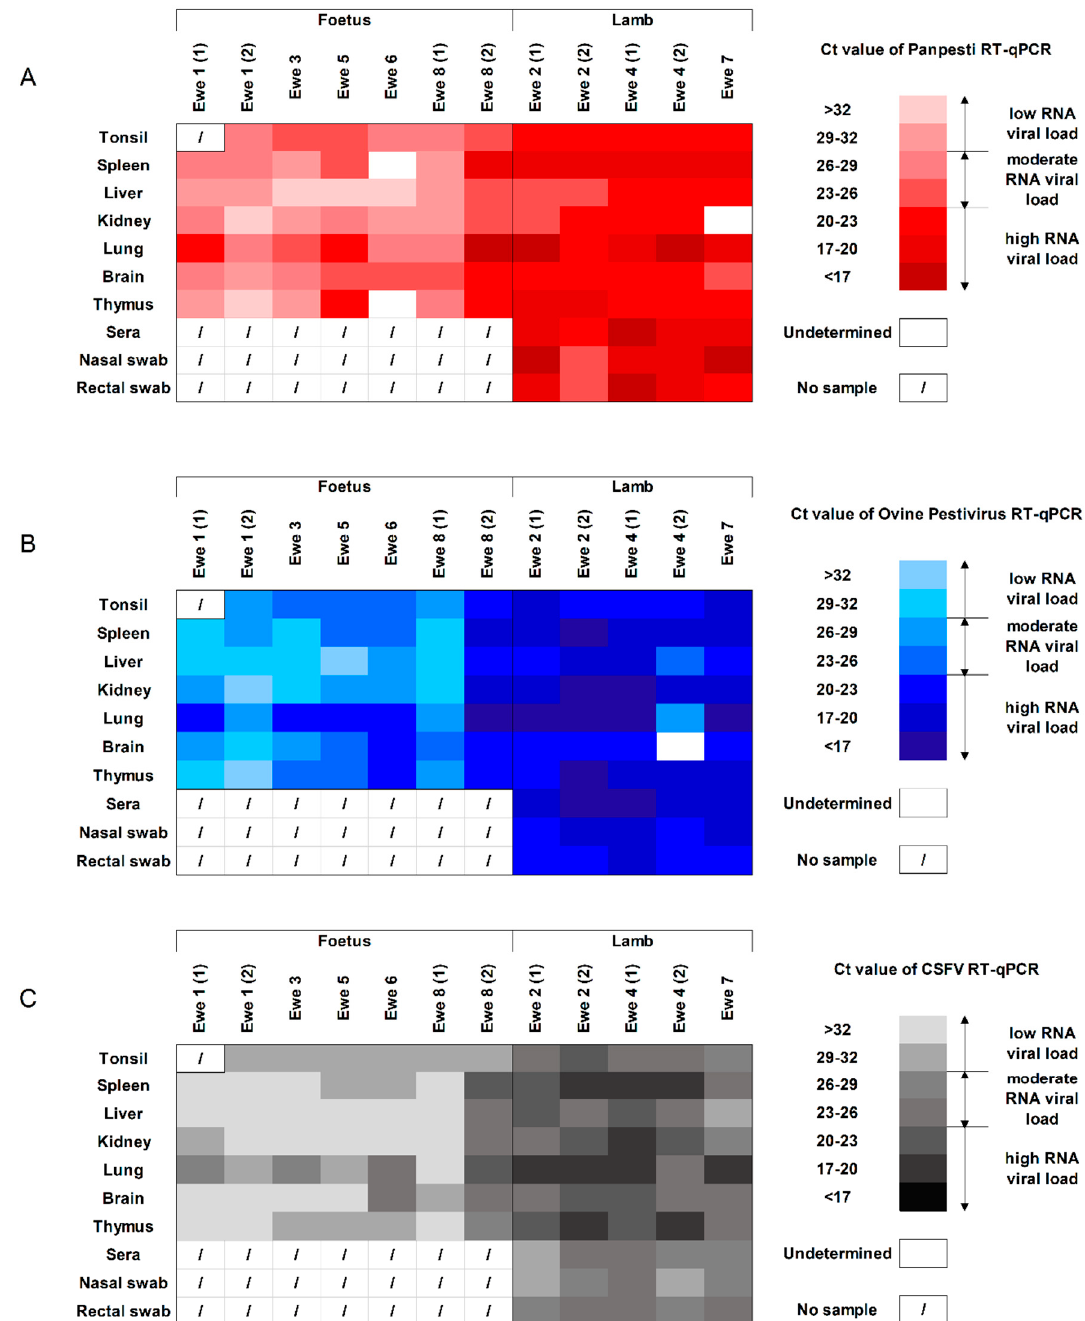
Figure 4. Detection of OVPV RNA in samples and tissues from foetuses and lambs. The OVPV RNA analyzed by (A ) Pestivirus RT-qPCR [21], ( B ) the new specific OVPV RT-qPCR, and ( C ) specific CSFV RT-qPCR [22]. The RNA load, according with the Ct value, is represented as low, moderate, or high by the intensity of the red, blue and gray colors in the scale for ( A ), ( B ), and ( C ), respectively. Ct values above 40 were considered as negative.